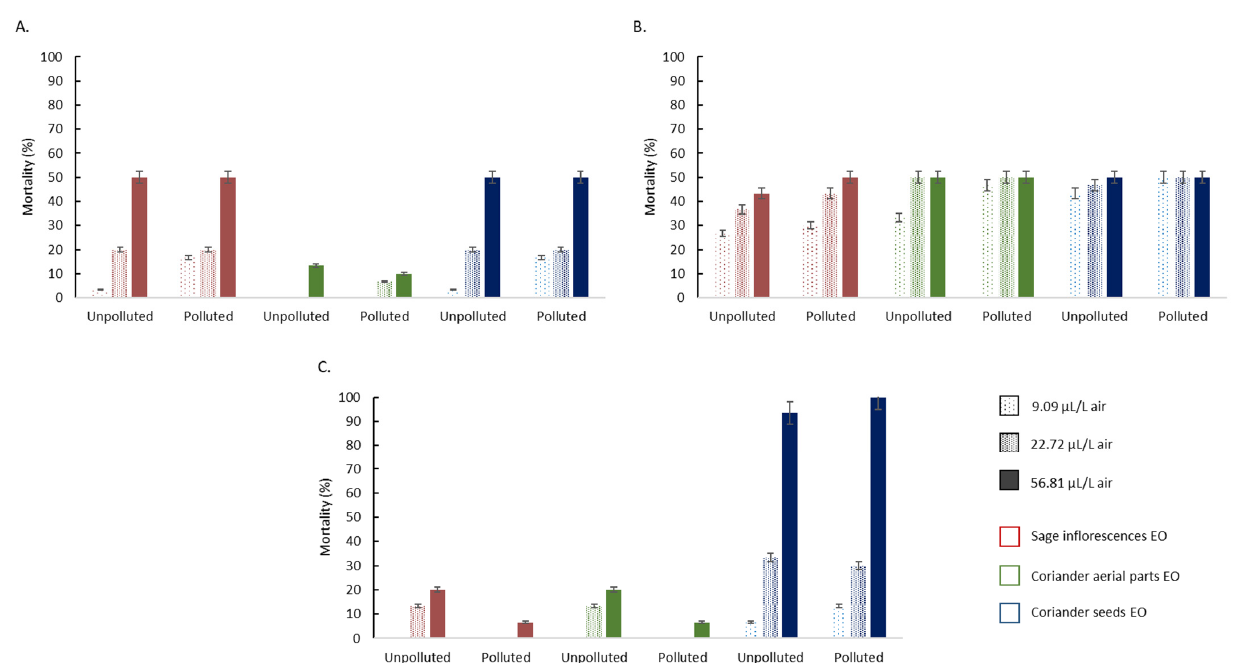
Figure 3. Mortality rates (%) of E. kuehniella ( A ), B. tabaci ( B ) and R. dominica ( C ) adults, exposed during 24 h to three EO (clary sage, coriander aerial parts and coriander seeds) at different concentrations (n = 3).